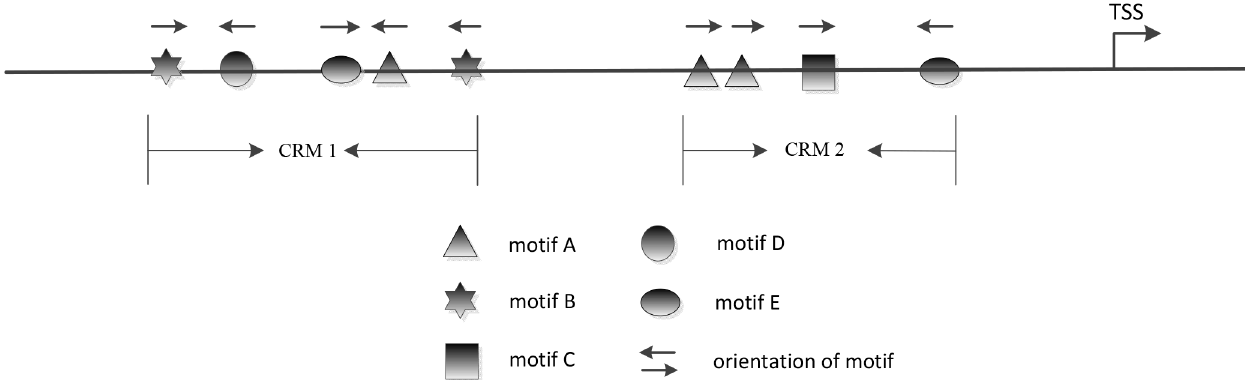
Fig 1. Regulatory structure of a CRM. A CRM is a sequence segment that contains instances of multiple motifs. The orientations of the motifs, the distance between motifs and the relationships between motifs may be key properties of